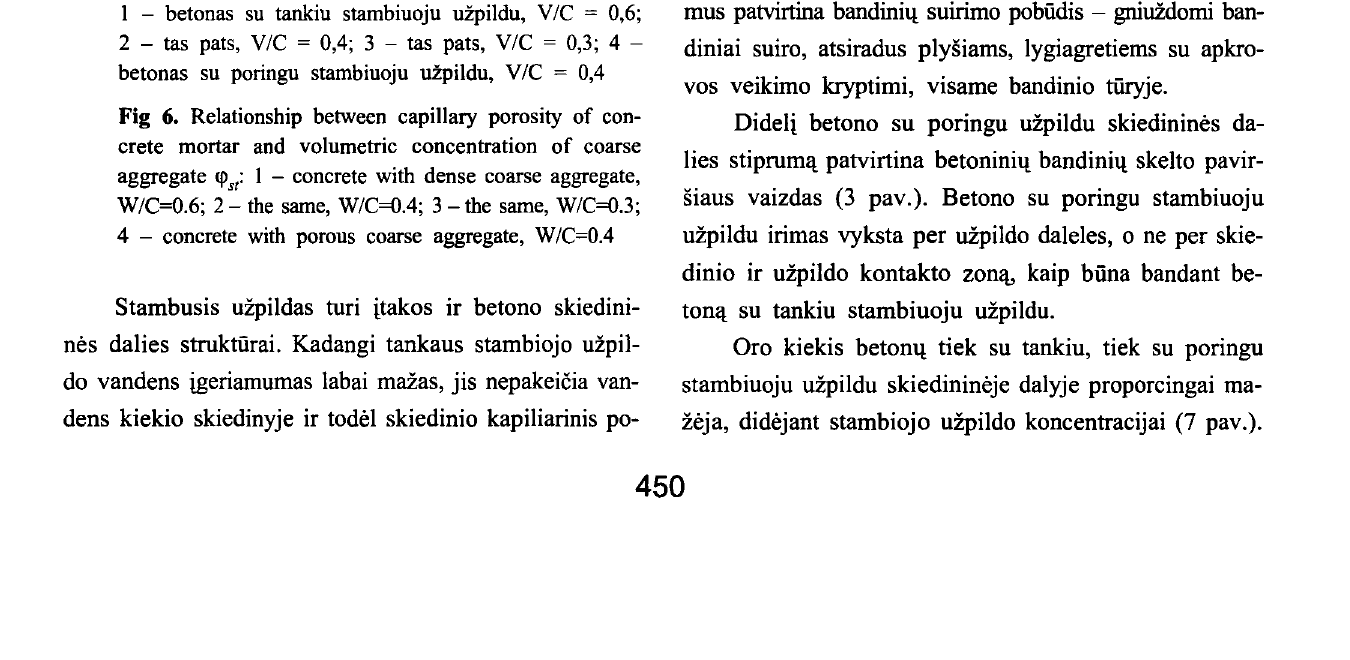
7 pav. Oro kiekio betono skiedinineje dalyje priklauso betonas su tankiu stambiuoju uZpildu, V/C = 0,6; 2 - tas pats, V/C = 0,4; 3 - tas pats, V/C = 0,3; 4 - betonas su poringu stambiuoju uZpildu, V/C = 0,4 Fig 7. Relationship between entrained air content in the concrete mortar and volumetric concentration of coarse aggregate <ps 1: 1 - concrete with dense coarse aggregate, W/C=0.6; 2 - the same, W/C=0.4; 3 - the same, W/C=0.3; 4 - concrete with porous coarse aggregate, W/C=0.4 ringumas islieka pastovus, didejant tankaus